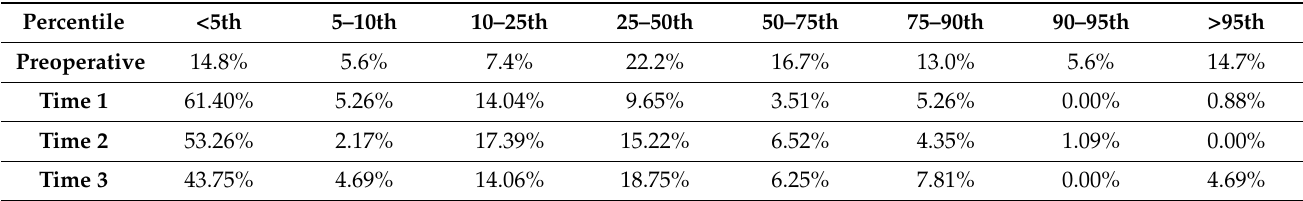
Table 5. LVGL ε values distribution as percentiles at different time